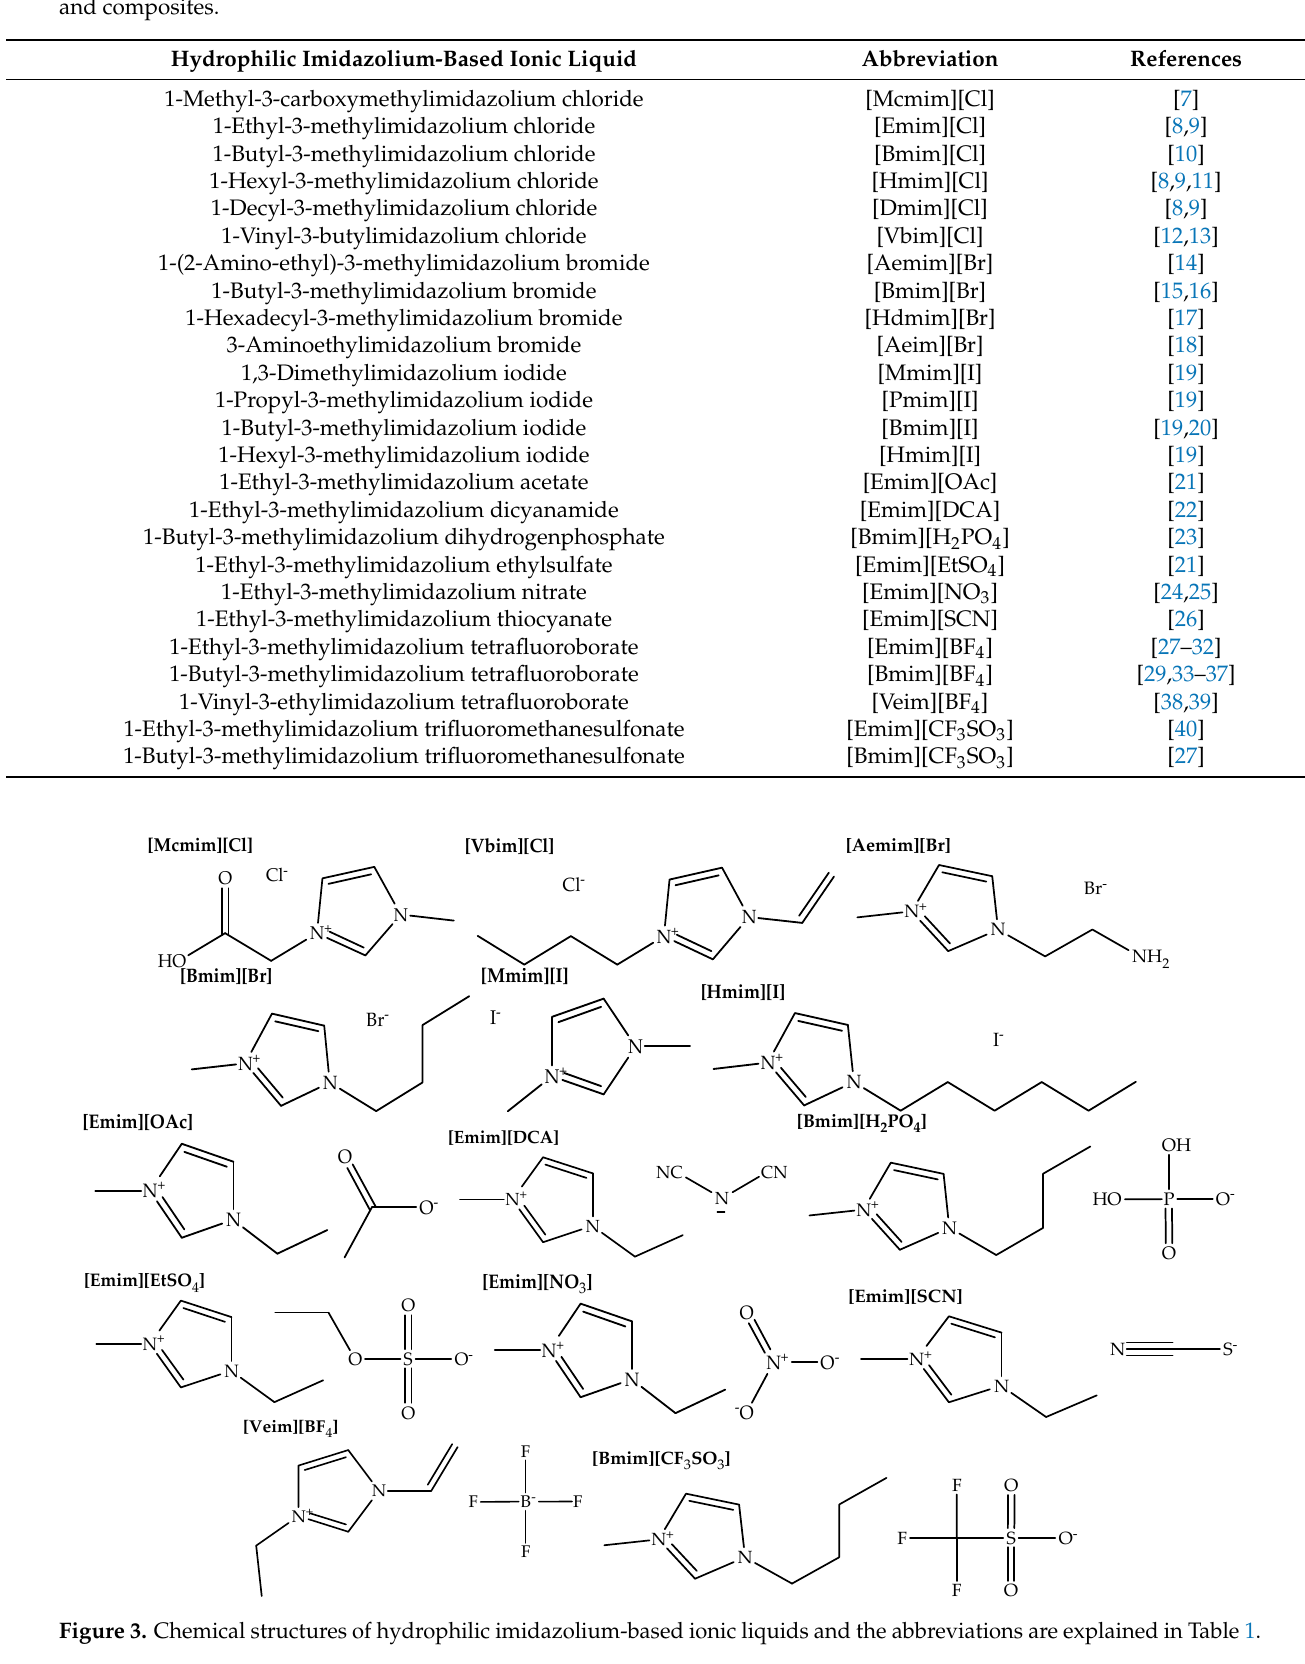
Table 1. Examples of hydrophilic imidazolium-based ionic liquids utilized for preparation of PVDF and PVDF-HFP blends and composites.